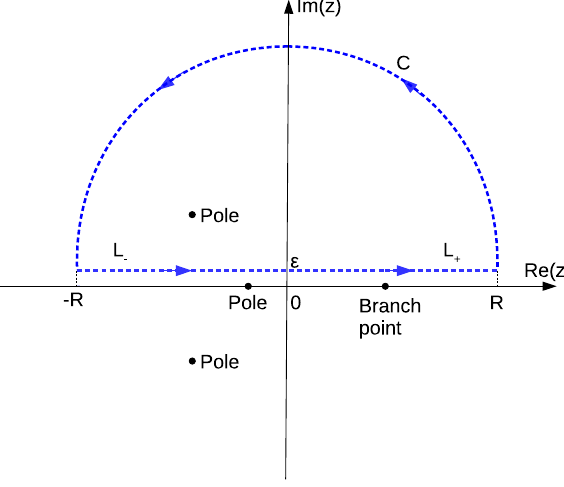
Fig. 2 A sketch of the procedure to obtain N (cid:10) in the complex plane. Here we consider a propagator displaying three poles (one real and two complex conjugates), and a possible new branch point that may appear. We choose to close the contour in the upper half of the complex plane in a way that every possible real pole and the branch cut is avoided. Thus, the contour (cid:10) is defined by the semi-circle C of radius R plus the horizontal paths L − ( z ) and L + ( z ) , which are lifted up by an imaginary infinitesimal, i